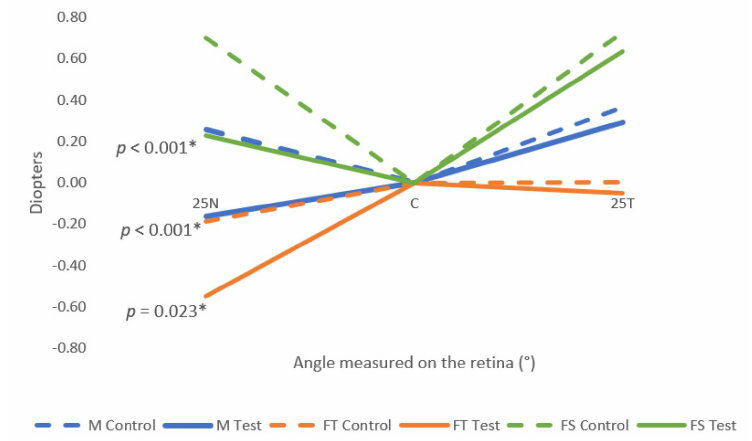
Figure 5. Relative mean values of M, FT, and FS for the three points measured (25T, C, 25N) for both control and test conditions. 25N: 25 ◦ eccentricity at nasal retina, 25T: 25 ◦ eccentricity at temporal retina. Standard deviation is not shown for clarity and can be consulted in Table 2. The symbol * marks the statistically significant differences ( p -value < 0.05).